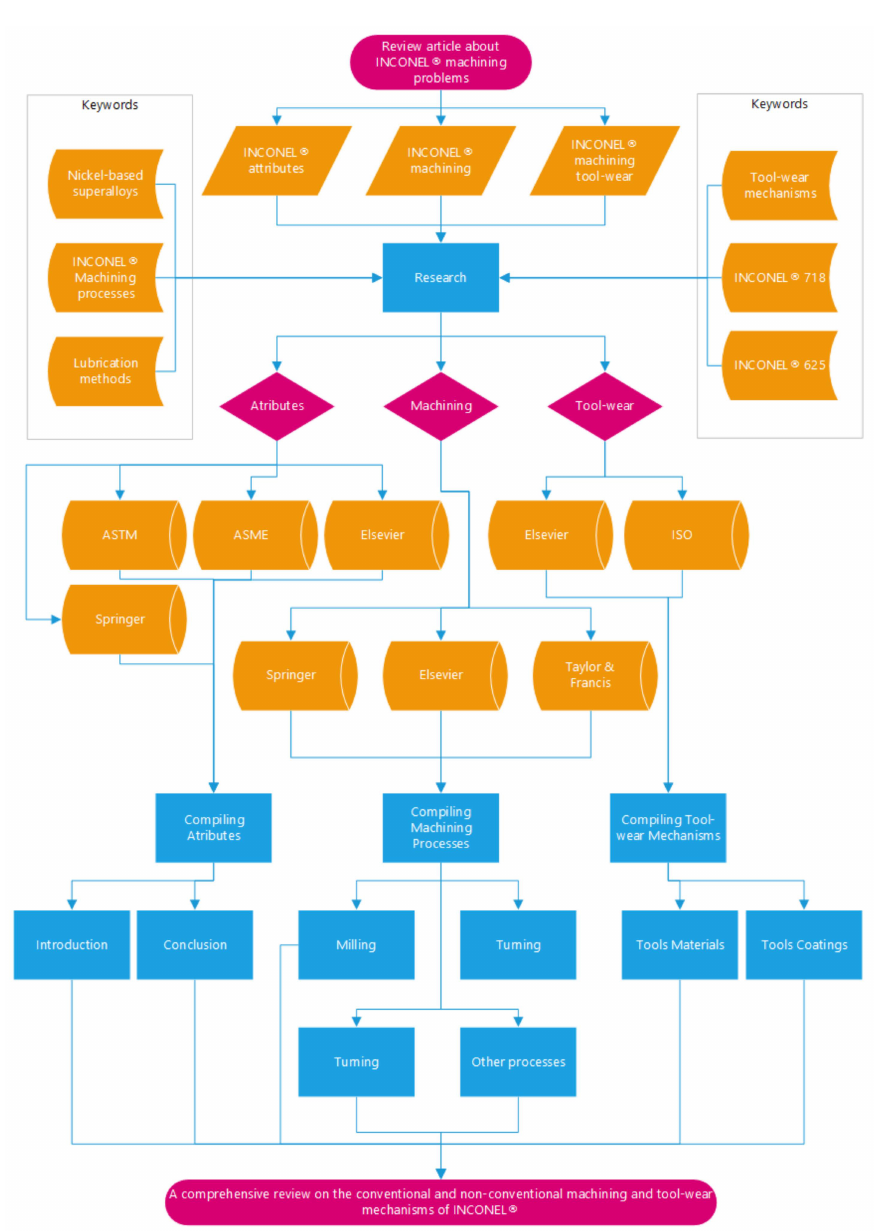
Figure 5. Research method accomplished to achieve a better redacting result to the review